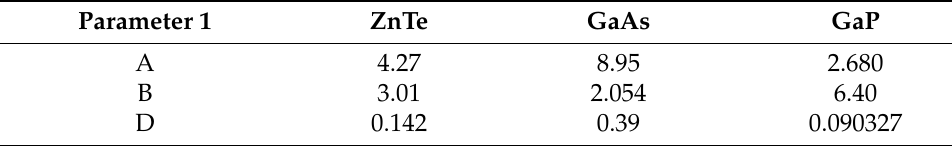
Table 1. Optical refractive index parameters